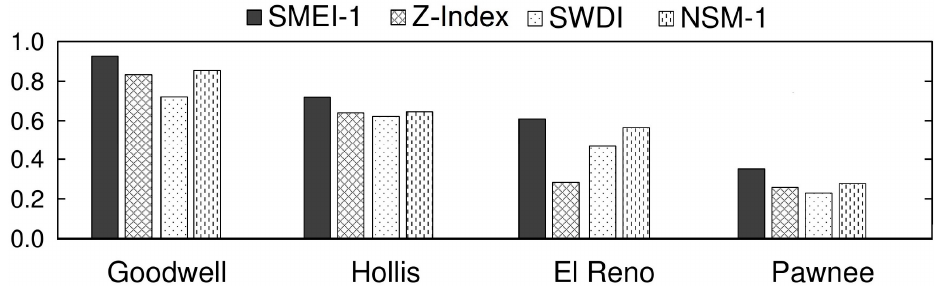
Figure 9. Correlation coefficients of existing indices and SMEI with winter wheat production during the spring period (months of March and April) at Goodwell ( a ), Hollis ( b ), El Reno ( c ), and Pawnee ( d ).